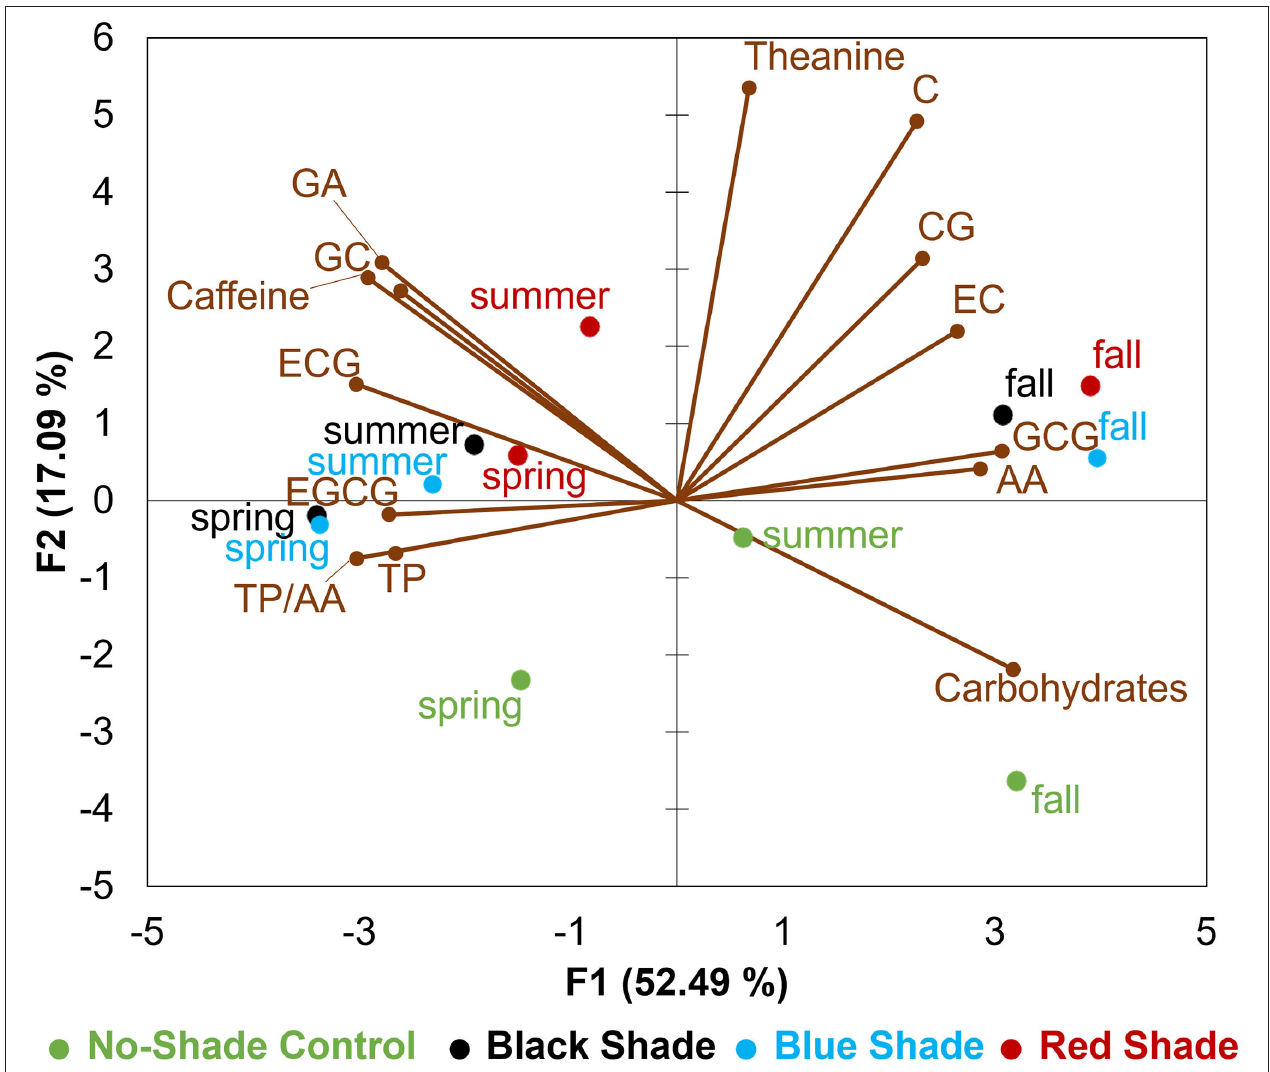
FIGURE 5 | Principle component analysis (PCA) biplot for chemical compositions in tea leaves collected from plants under different shade treatments in spring, summer, and fall. GA stands for gallic acid, ECG stands for epicatechin-3-gallate, EC stands for epicatechin, GCG stands for gallocatechin-3-gallate, AA stands for free AAs, CG stands for catechin-3-gallate, C stands for catechin, EGCG stands for epigallocatechin-3-gallate, TP stands for TPs, and GC stands for